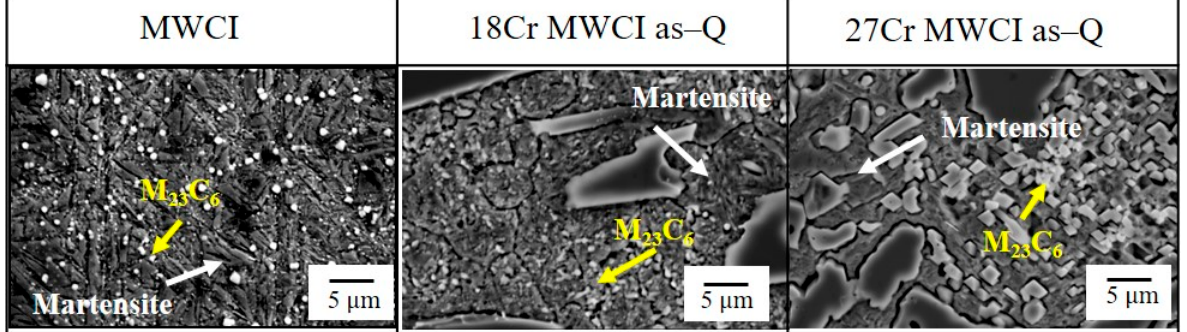
Figure 6. Microphotograph of matrix and secondary carbide precipitation with higher magnification SEM.